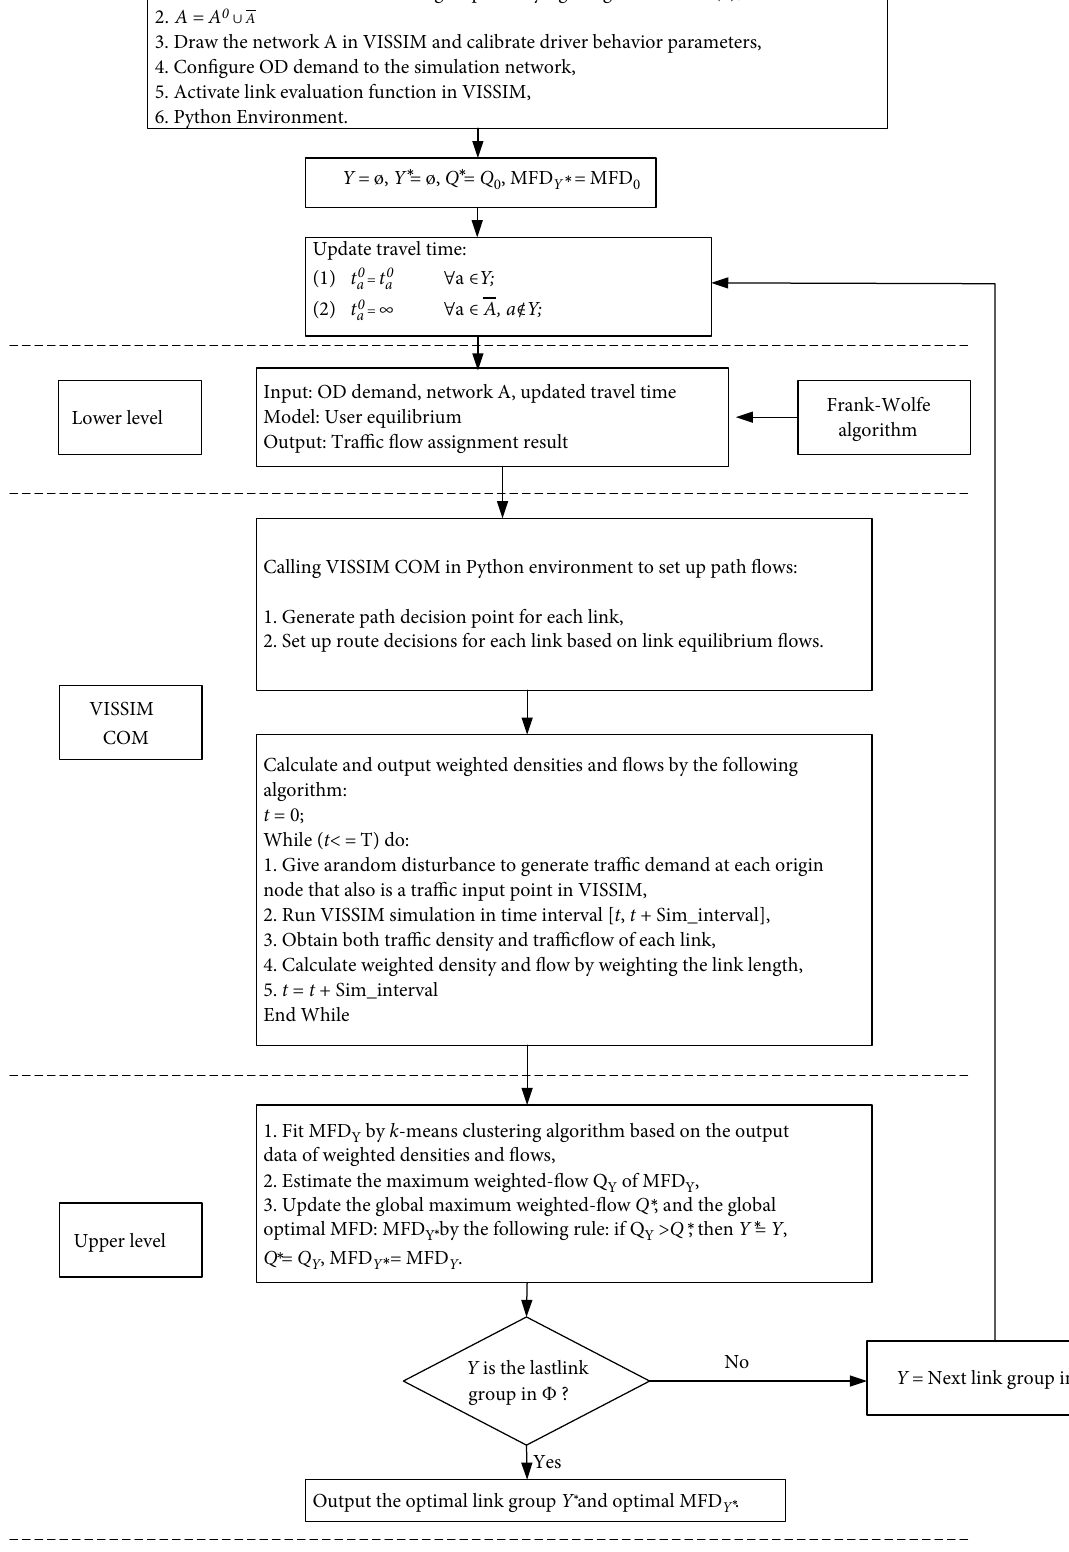
Figure 2: Algorithmic framework for solution